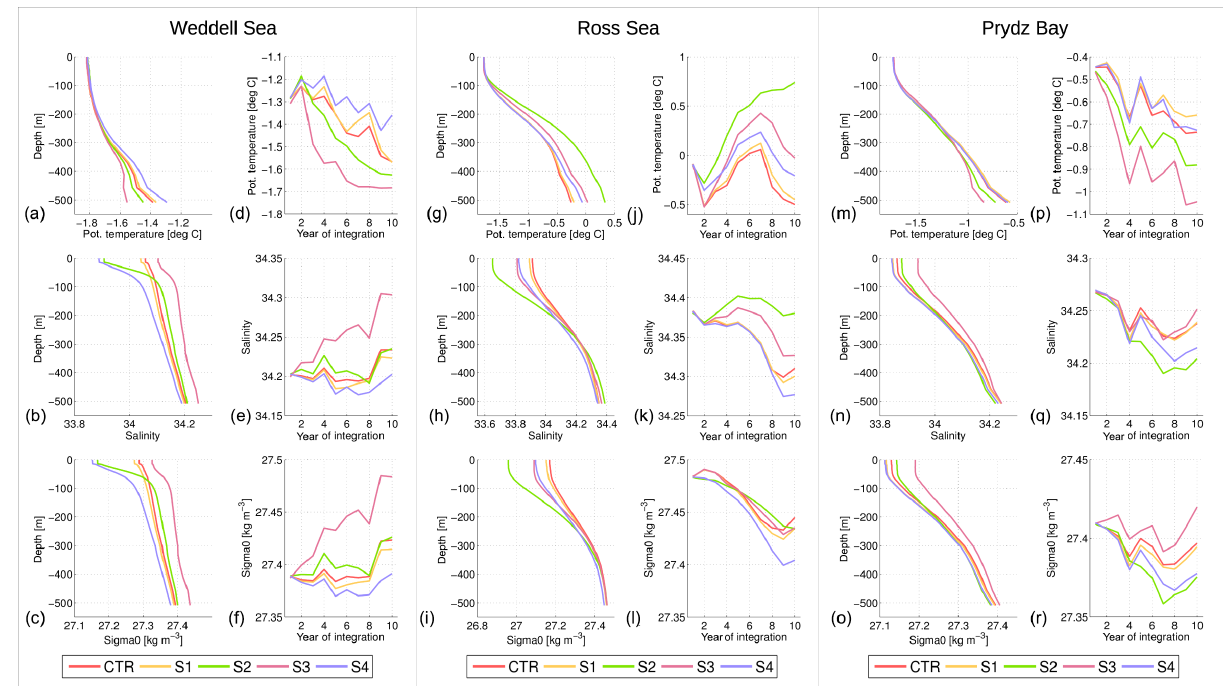
Figure 5. Mean vertical profile ≤ 550m depth (left) and annual mean values at the 550m isobath (right) of potential temperature, salinity, and sigma0 in April–September 2004–2013 in the (a–f) Weddell Sea, (g–l) Ross Sea and (m–r) Prydz